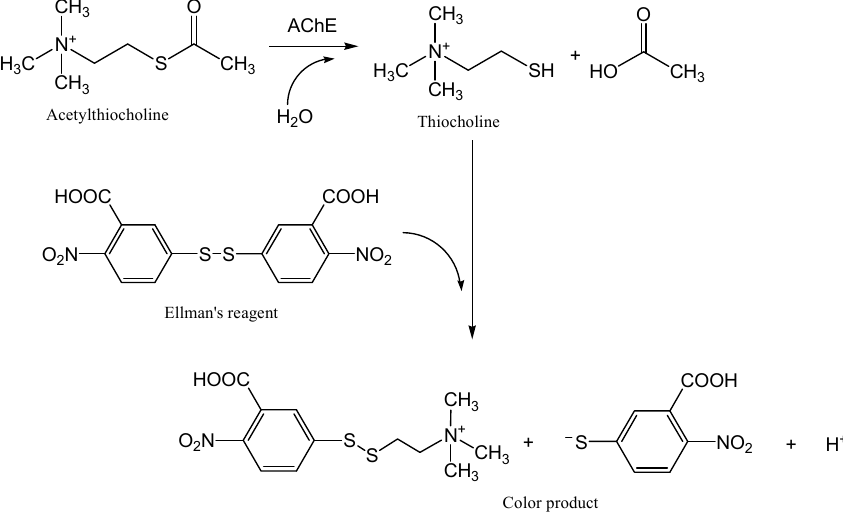
Figure 2. The schematic depiction of the analytical reaction in the biosensor Detehit.